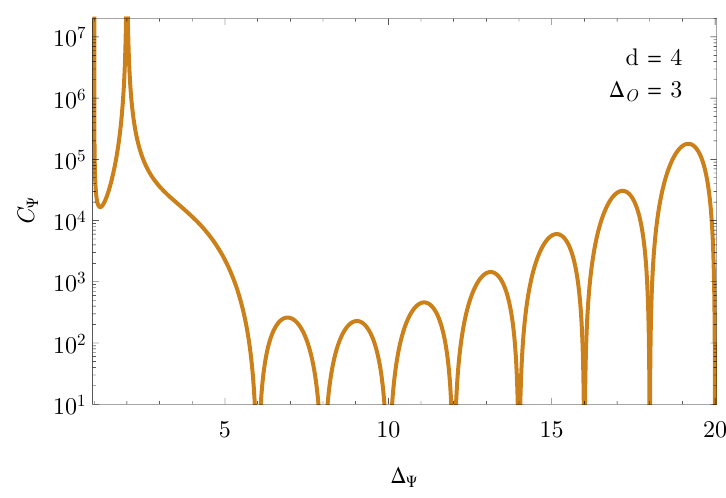
Figure 5 . The coe(cid:14)cient C (cid:9) of eq. (3.36) for a scalar intermediate operator (cid:9) in d = 4. The zeroes of C (cid:9) when (cid:1) (cid:9) = 2(cid:1) O + 2 n are visible, as are the UV divergences at (cid:1) (cid:9) = d= 2 and ( d (cid:0) 2) = 2. At large (cid:1) (cid:9) , the coe(cid:14)cient C (cid:9) increases